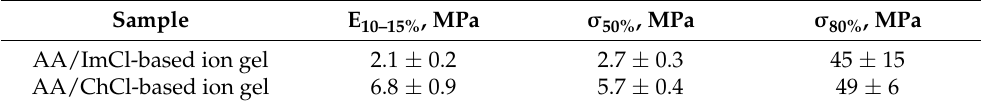
Table 1. Mechanical properties of AA/ChCl- and AA/ImCl-based polymerized ion gels measured in compression mode for samples prepared by bulk polymerization.